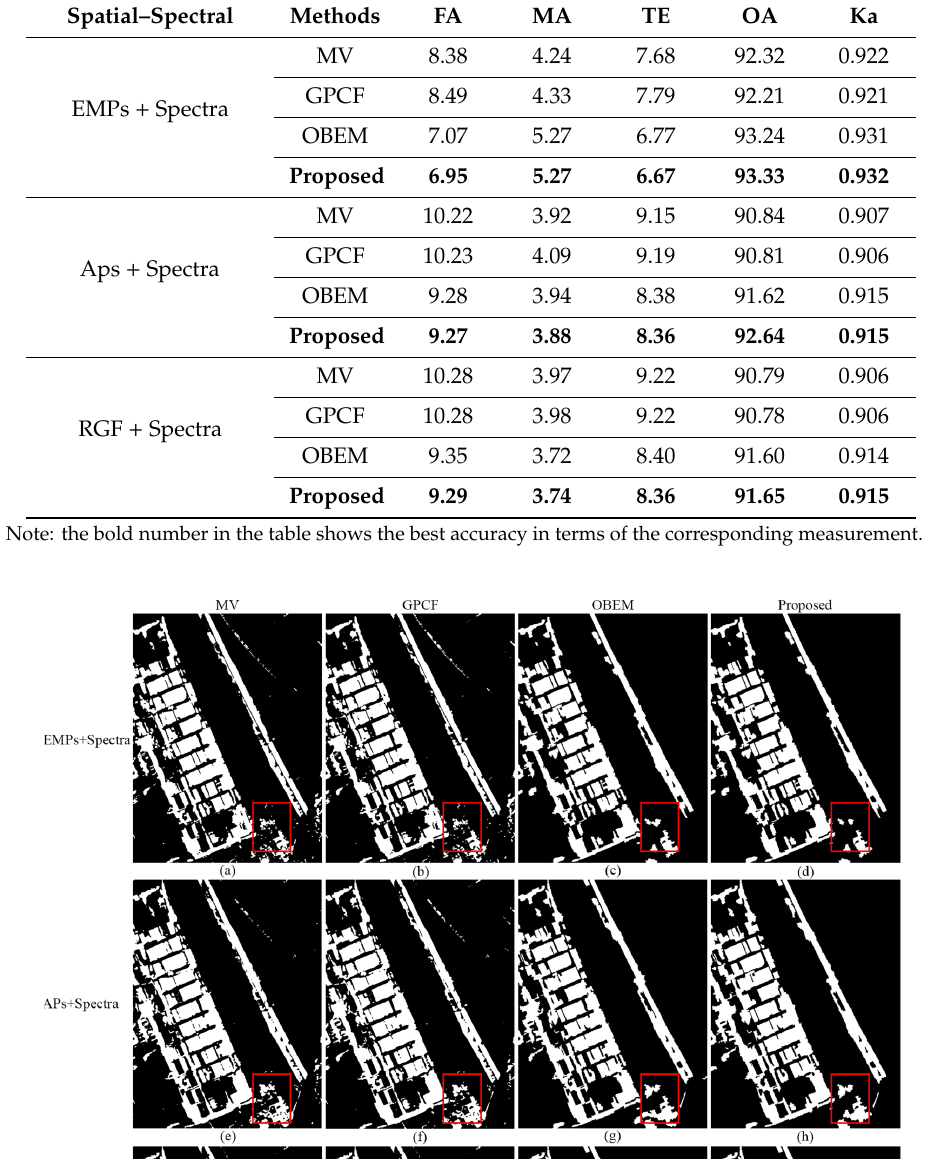
Table 9. Quantitative comparisons (%) between the proposed approach and three post-processing methods with different spatial–spectral feature fusion strategies in the Ji’Nan QB satellite images. Spatial–Spectral